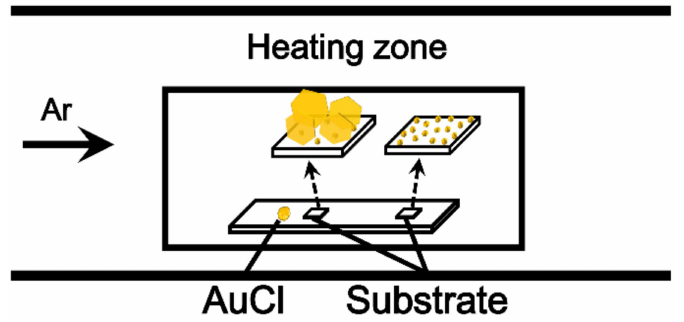
Figure 1. Schematic illustration of the vapor-phase synthesis of Au nanostructures (NSs) at low temperature. When the substrate was placed 15–20 mm away from AuCl, Au NPs were grown on the substrate. When the substrate was placed 3–5 mm away from AuCl, Au nanoplates were obtained on the substrate.